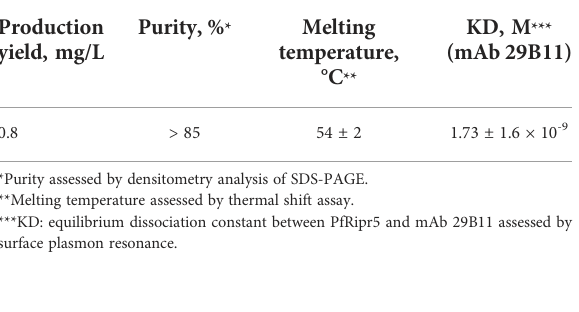
TABLE 1 Characterization of puri fi ed PfRipr5.